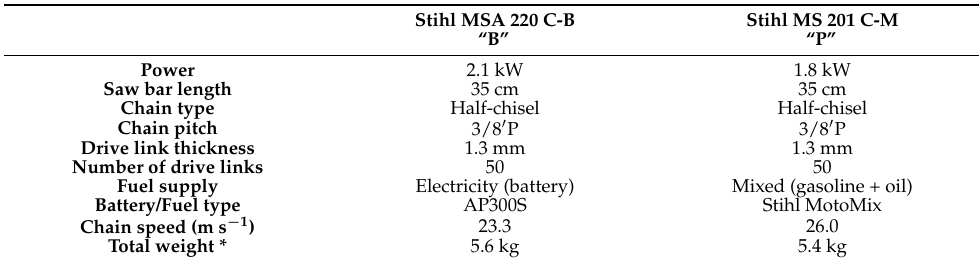
Table 1. Technical characteristics of the two chainsaws used in the